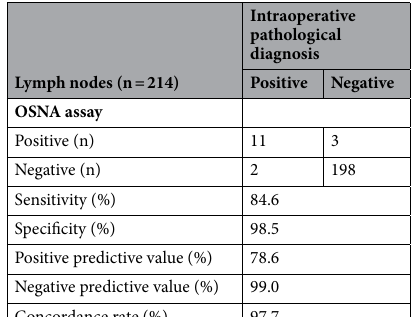
Lymph nodes (n = 214)